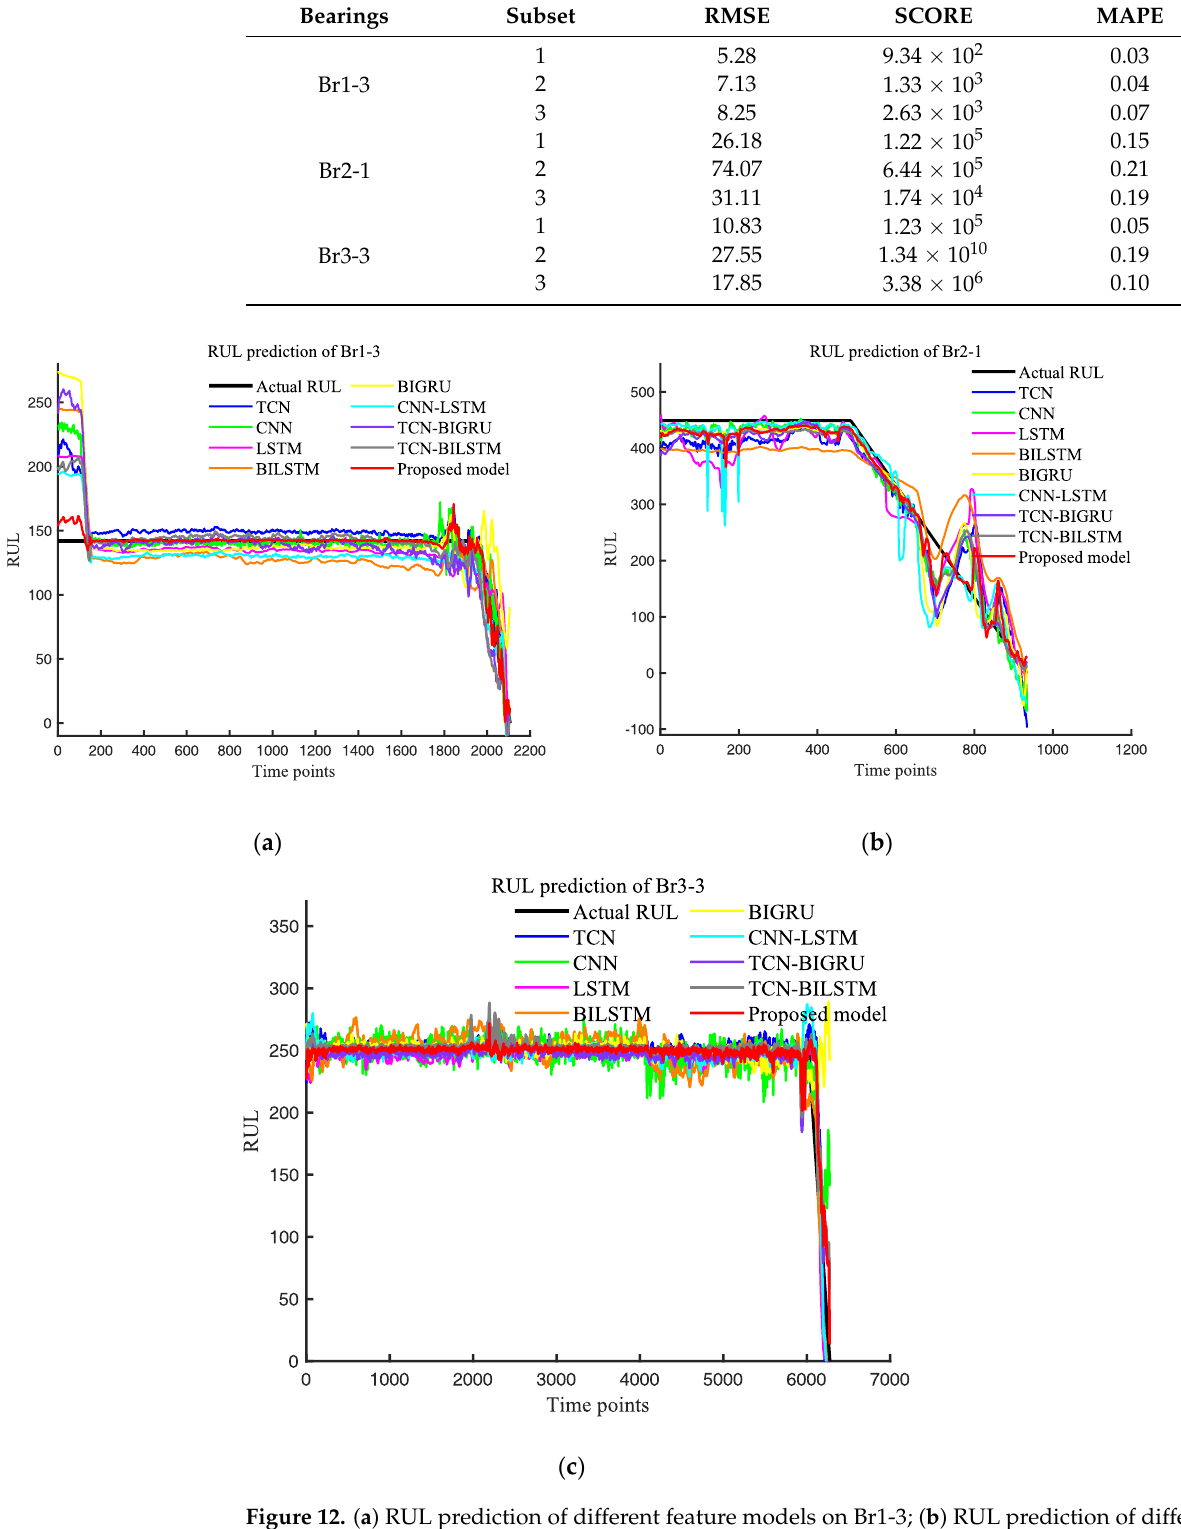
Figure 12. ( a ) RUL prediction of different feature models on Br1-3; ( b ) RUL prediction of different feature models on Br2-1; ( c ) RUL prediction of different feature models on Br3-3. Table 7. Evaluation indexes for different models.